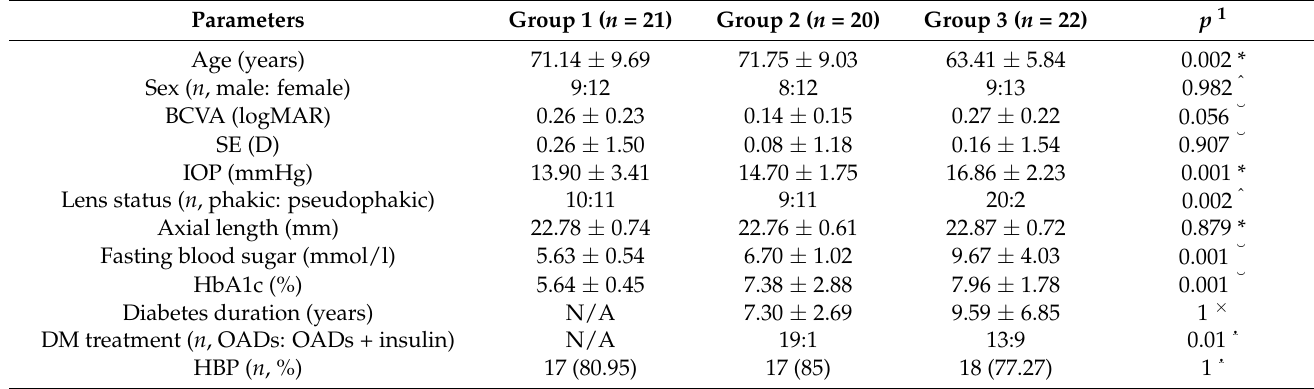
Table 1. Demographical, ocular, and biochemical characteristics in the study groups. Parameters